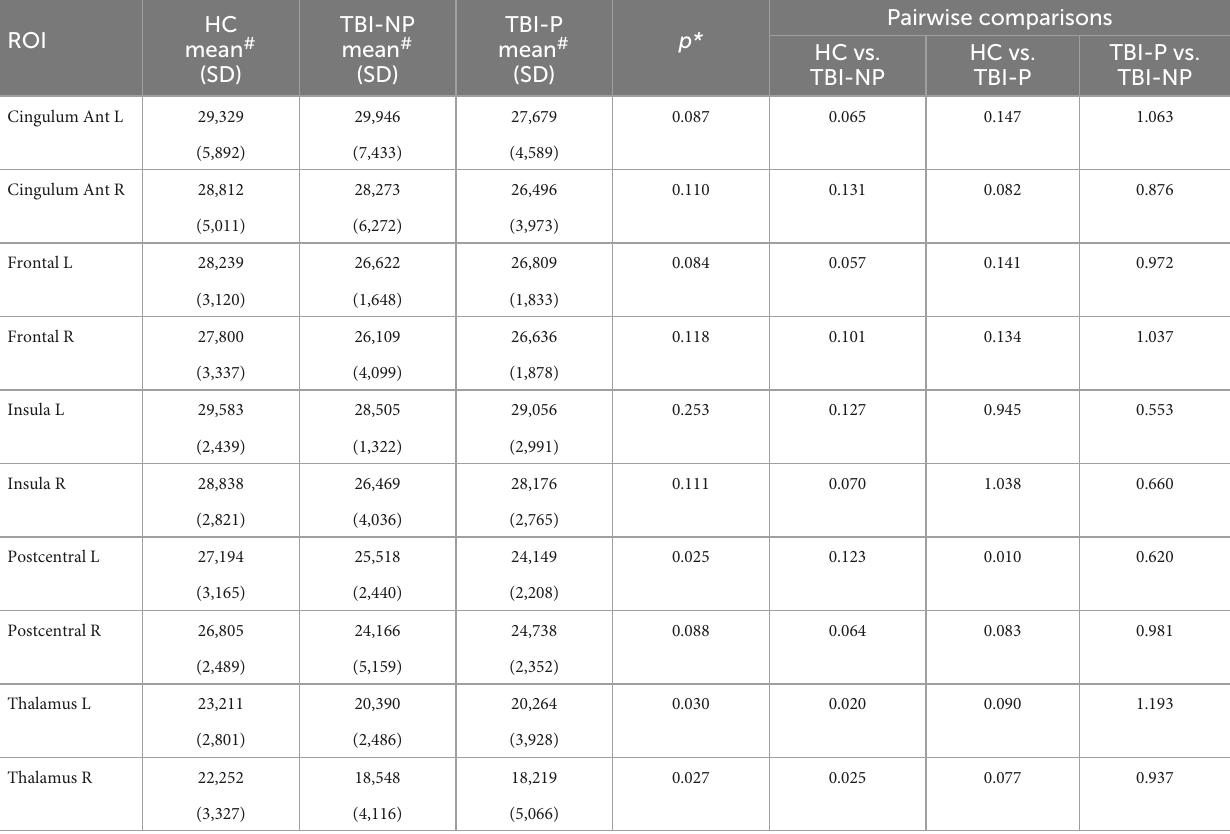
TABLE 7 Results from analysis of covariance (ANCOVA) controlling for age between HC ( N = 31), TBI-NP ( N = 17) and TBI-P ( N = 16) groups for total creatine (tCre).